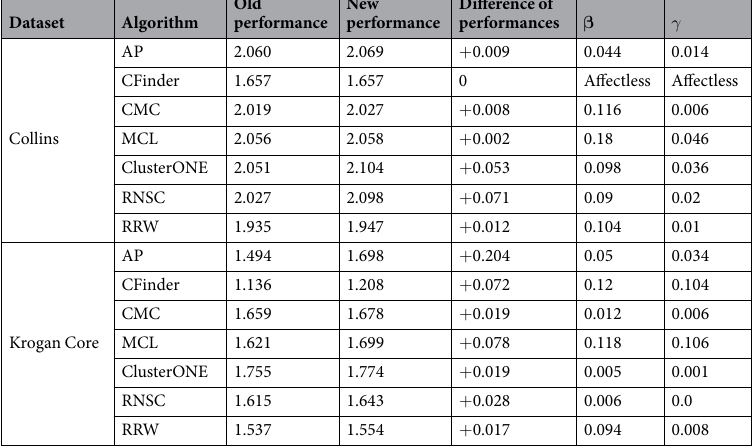
Difference of performances β γ